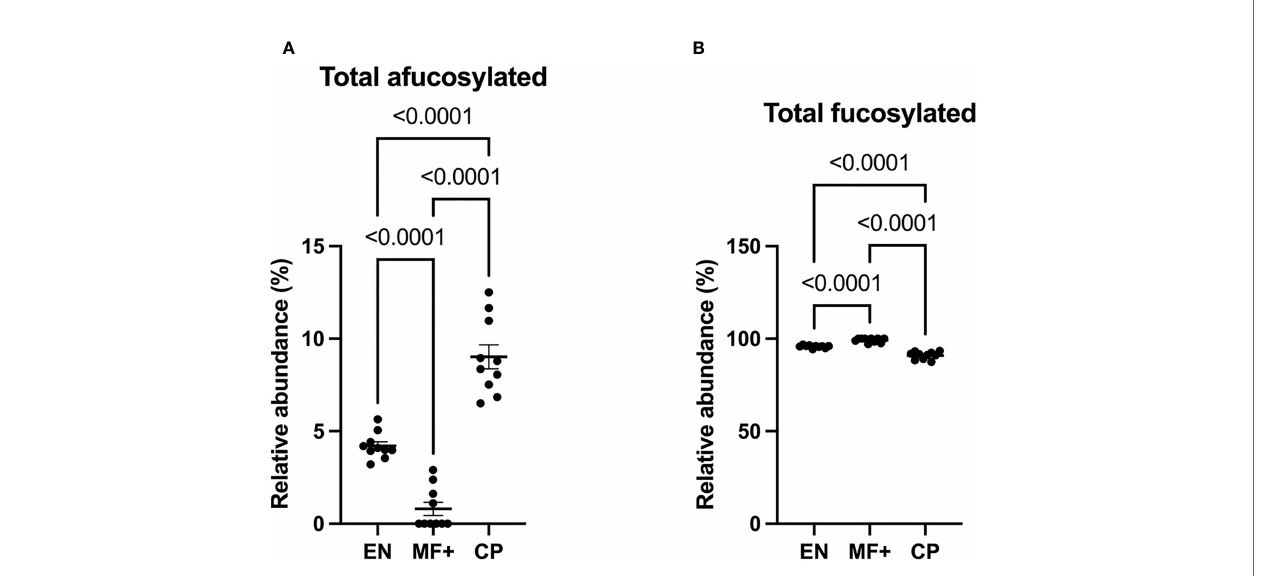
FIGURE 6 | Higher levels of afucosylated IgG are associated with CP. Graphs represent the relative abundance of IgG-bound glycan structures without (A) or with (B) fucose residues (A) in total IgG puri fi ed from EN, MF+, and CP patients. Dots represent individual donors. Bars represent means ± SEM. Statistical analyses were performed using the Kruskal – Wallis nonparametric test with Dunn ’ s multiple comparison post-test. Signi fi cance is accepted when P < 0.05.